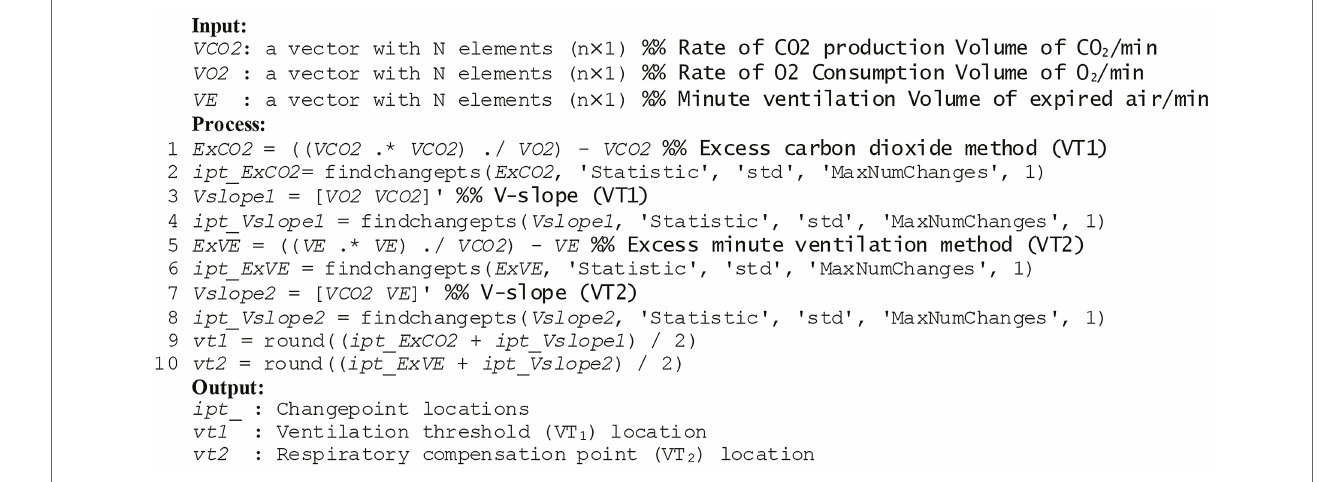
FIGURE 2 | Code for the suggested approach.